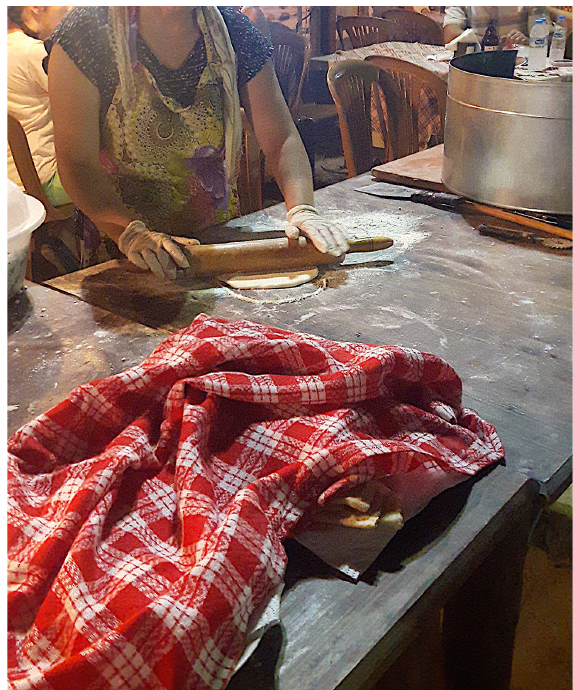
Figure 4. Turkish woman making gozleme . Photograph